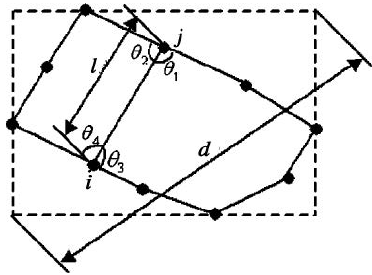
Fig. 6 Schematic diagram of area dividing